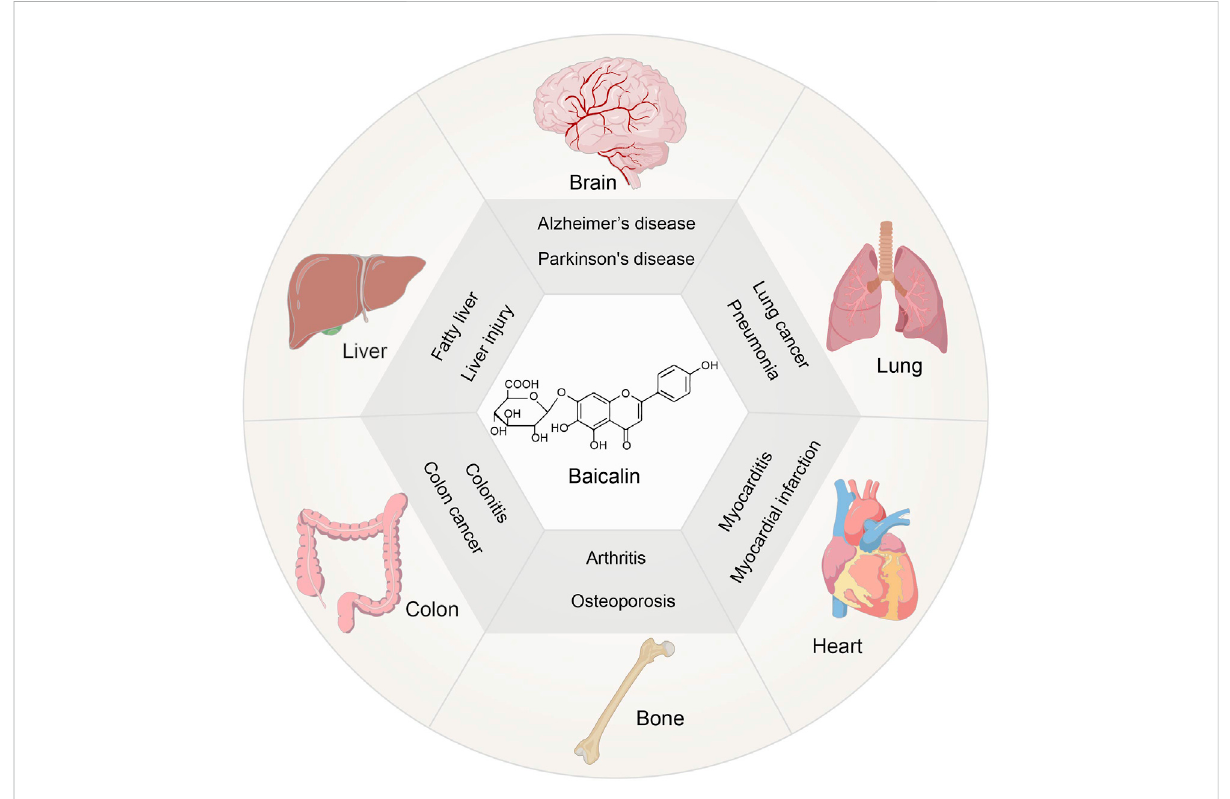
FIGURE 1 Chemical structure of Baicalin and its extensive pharmacological